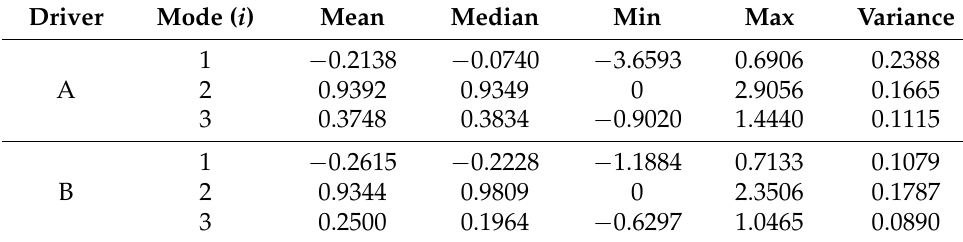
Table 3. Acceleration statistics for each mode i